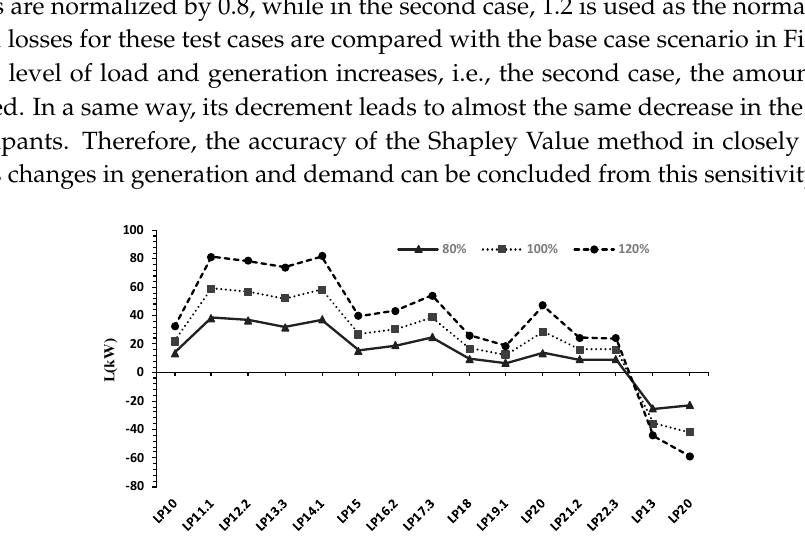
Figure 7. Allocated losses for the scenario with DG units .